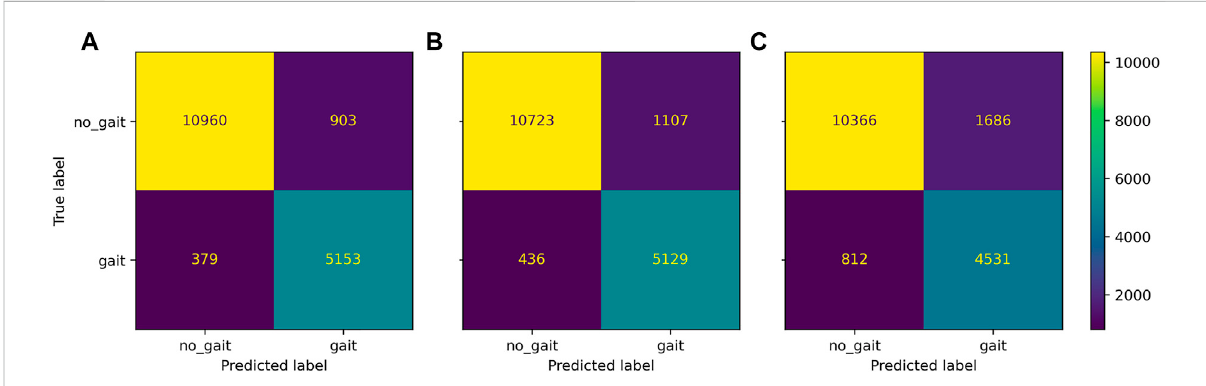
FIGURE 4 Confusionmatrixof Gait classi fi cationtaskforthethreedistrictsensorsetups:bilateralsetupallsensors, (A) ,unilateralsetupnon-affectedankle and wrist sensor, (B) , wrists-only setup (C)